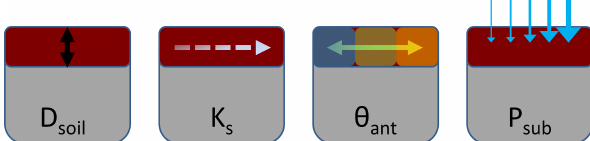
Figure 3. The four properties that were varied to explore their in- fluence on the shape and scale of TTDs: soil depth D soil , saturated soil hydraulic conductivity K S , antecedent soil moisture θ ant and subsequent precipitation amount P sub . The bedrock hydraulic con- ductivity K Br was kept constant for all of these base-case